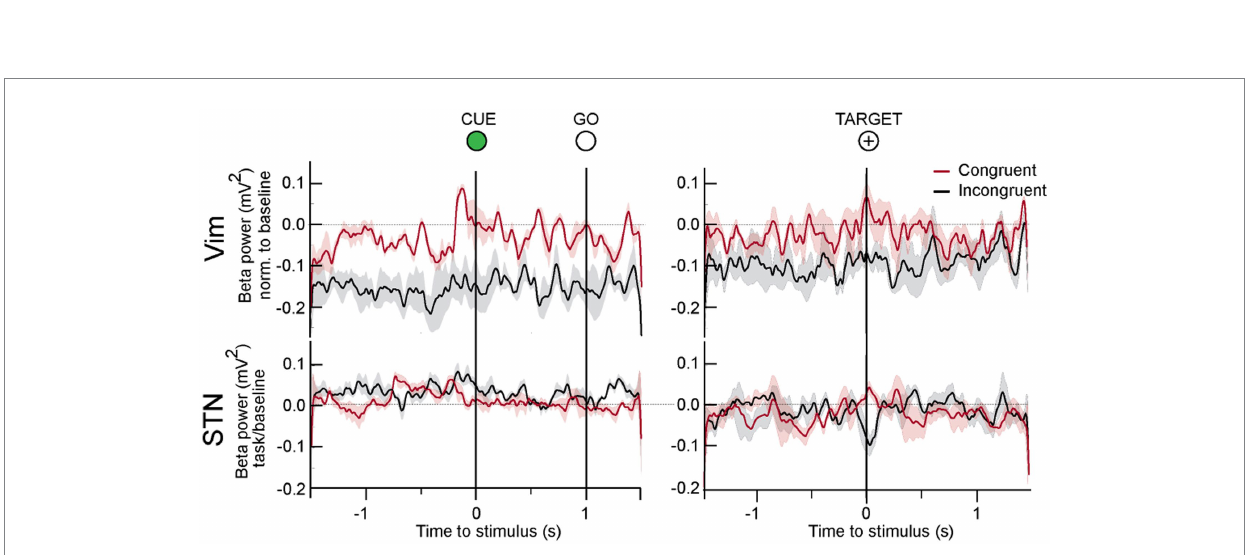
FIGURE 5 LFP responses to center out task in all patients. In the Vim of ET patients, beta activity was significantly lower during the whole duration of the incongruent center out task. In the movement preparation phase between CUE and GO, beta power increased in both tasks, although it was significantly lower in the incongruent condition. On approach to target, beta power was high in the congruent but lower in the incongruent orientation.